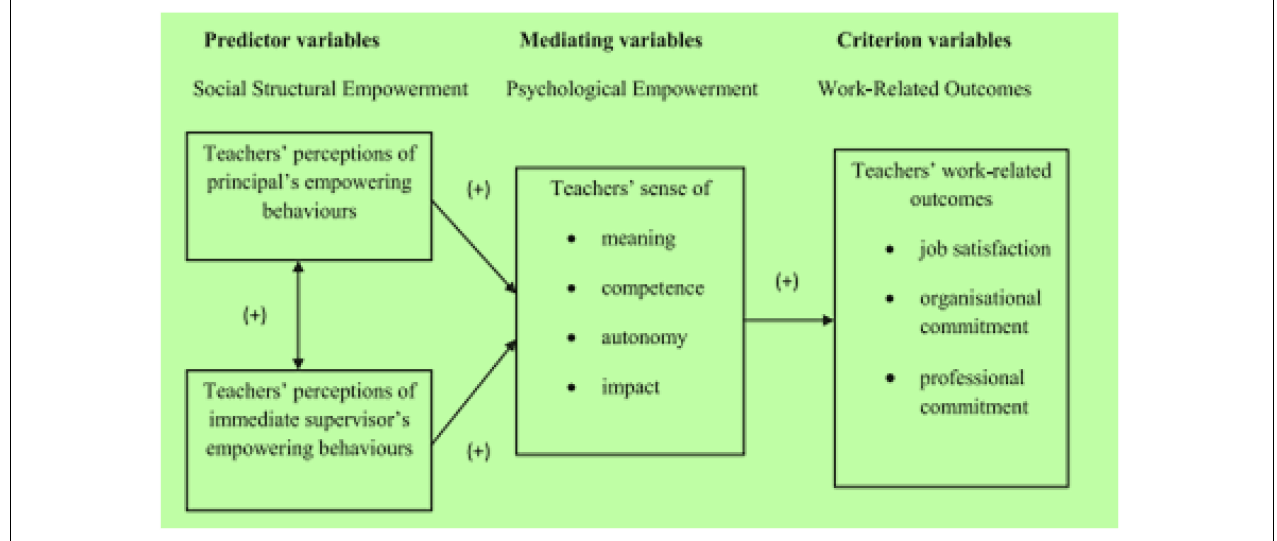
FIGURE 1 | A Theoretical model of teacher empowerment (Lee and Nie, 2014, p.